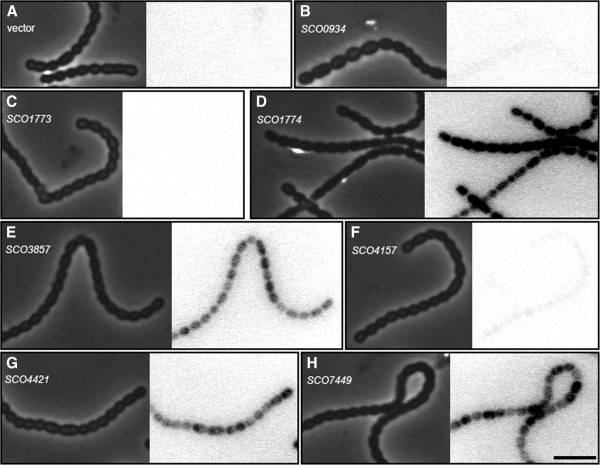
Promoter activity in developing spores. Derivatives of S. coelicolor strain M145 carrying different putative promoters fused to a promoterless mCherry were grown on MS agar to form spores. Spores were analyzed by phase contrast (left panel) and fluorescence microscopy (right panel), to detect the mCherry signal derived from activity of the specific promoters. As controls for hyphal autofluorescence, strain M145 carrying the empty vector pKF210 (A) was also investigated. The investigated putative promoter regions are localized immediately upstream of genes SCO0934(B), SCO1773(C), SCO1774(D), SCO3857(E), SCO4157(F), SCO4421(G), and SCO7449(H). Representative images are shown here, and quantitative analysis in Table 
1. Scale bar, 4μm.